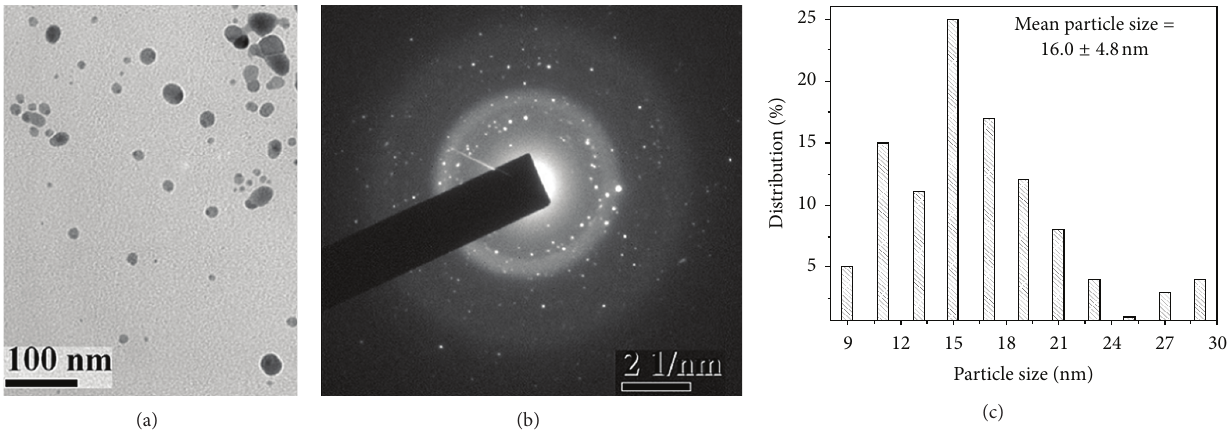
Figure 4: TEM images of PVP stabilized silver nanoparticle, at (a) 100 nm scale, (b) corresponding SAED pattern, and (c) histogram showing the particle size